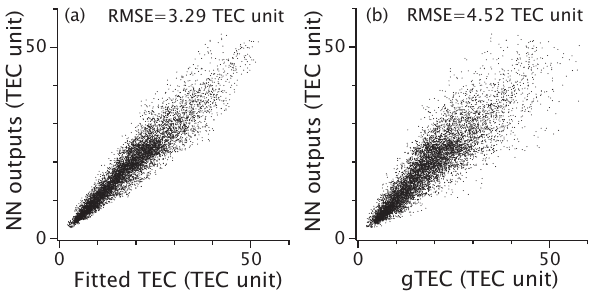
Fig. 10. Total performance of NN prediction. Scatter plots of NN- predicted hourly TEC for 2003 vs. TEC after functional fitting (a) and grid TEC before functional fitting (b)